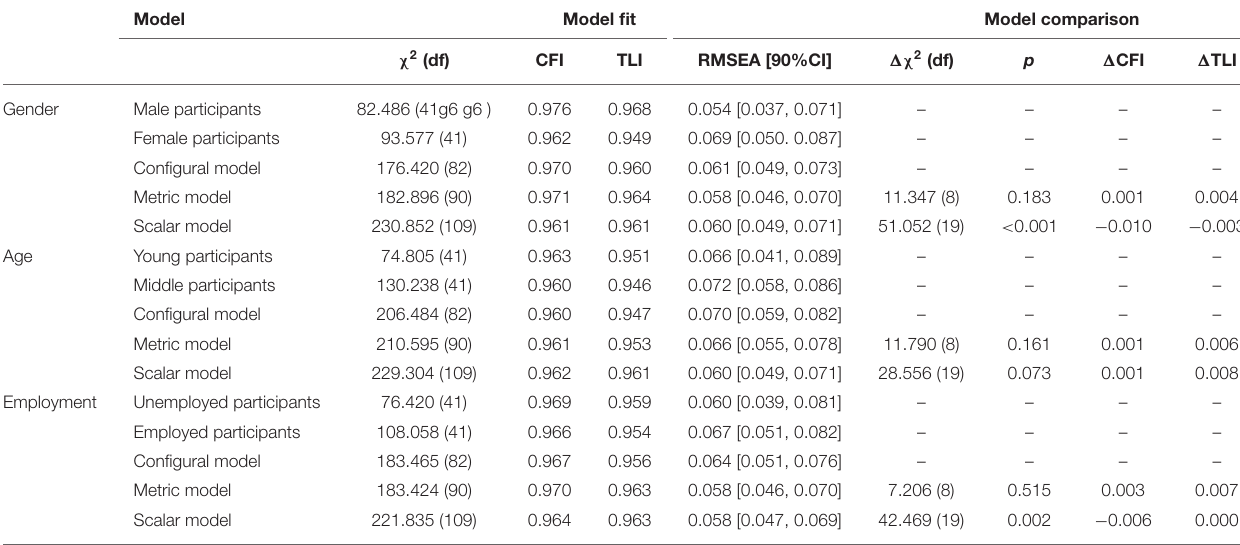
TABLE 5 | Measurement invariance across sex, age, and